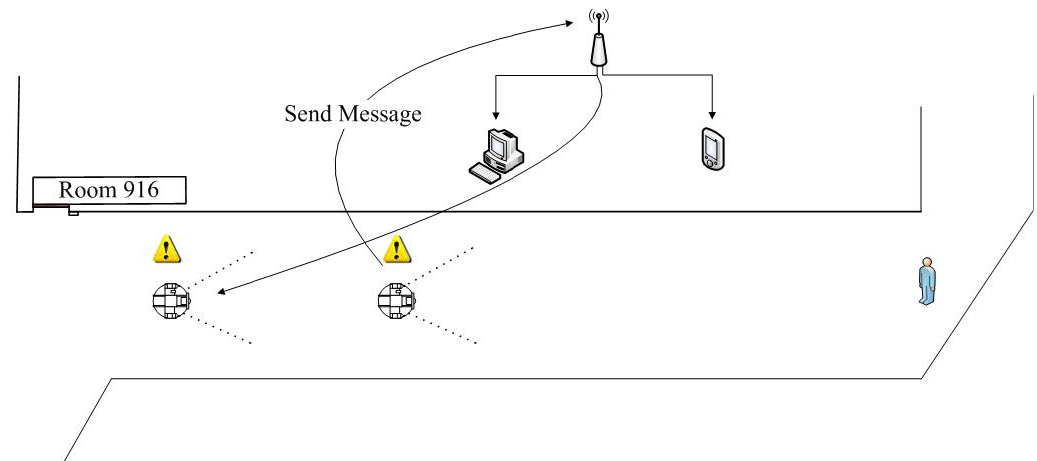
Figure 28. The first robot finds an intruder.